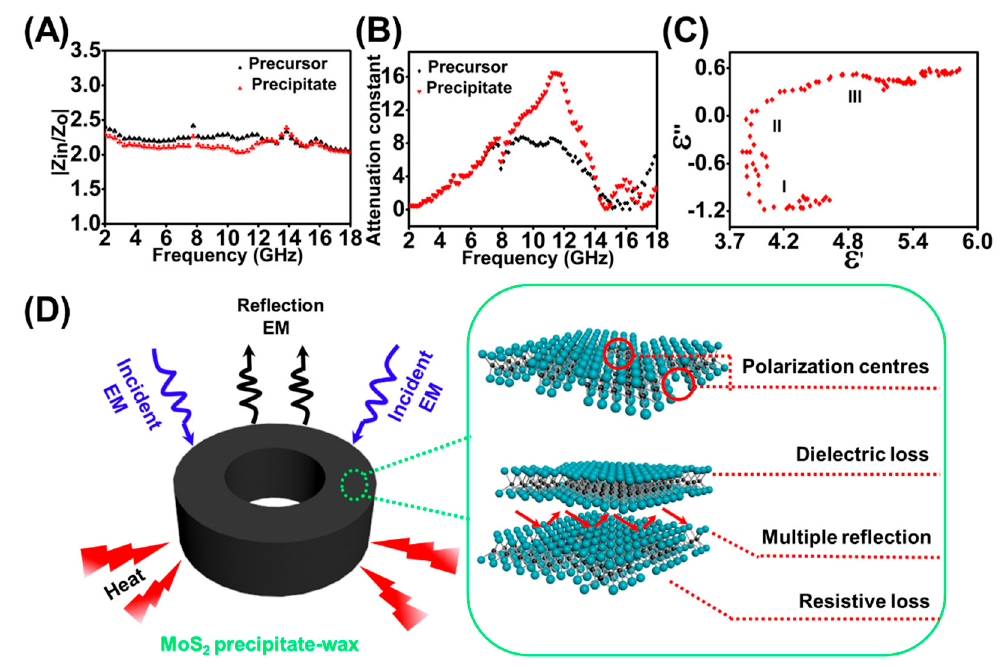
Figure 6. Z ratios ( A ) and α ( B ) of MoS 2 precursor–wax composites and MoS 2 precipitate–wax composites. ( C ) Cole–Cole plots for MoS 2 precipitate–wax composites. ( D ) The mechanism of high EM wave absorption efficiency based on the MoS 2 precipitate.